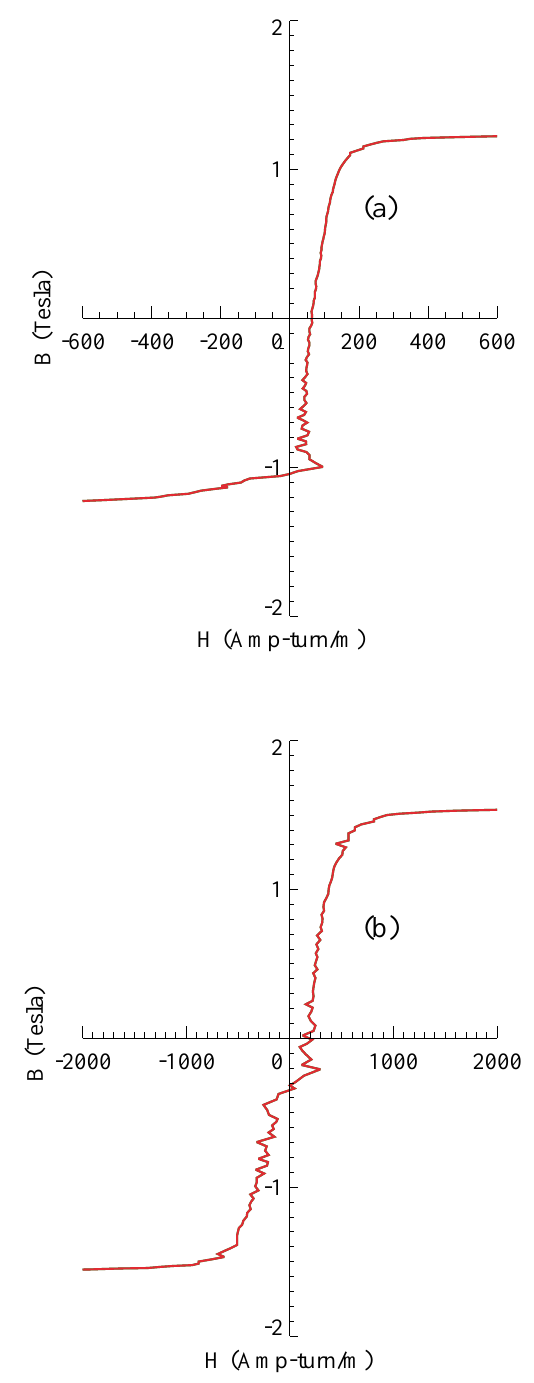
FIG. 4. (Color) (a) A partial B - H loop for a VITROPERM nanocrystalline core, manufactured by National Arnold Mag- netics, exhibits a high remanent field. (b) Potting a METGLAS 2605 SA1 core reduces the remanent field.